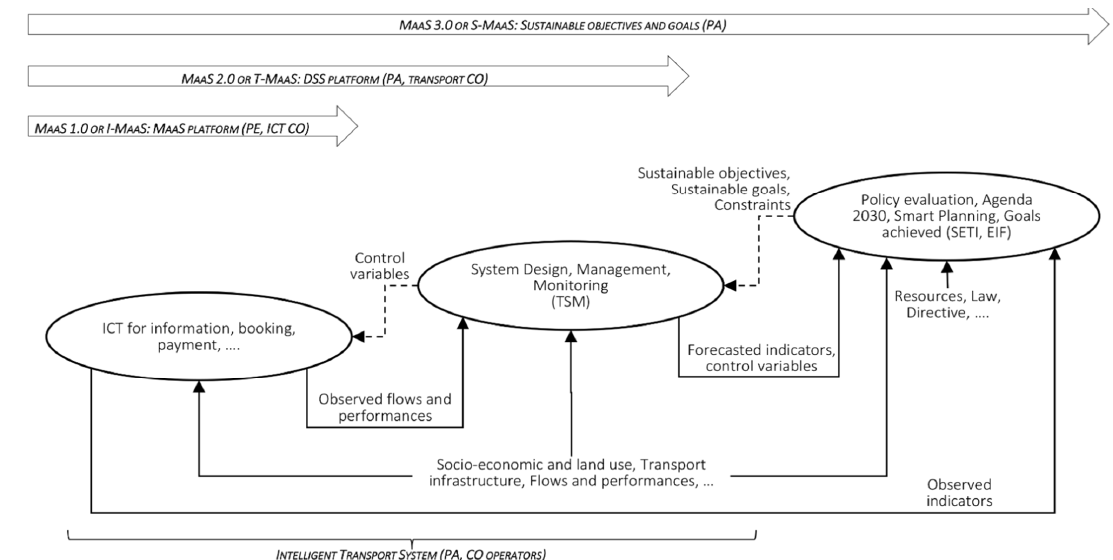
Figure 3. Architecture of MaaS 1.0, 2.0 and 3.0 and actors involved. MaaS 1.0, 2.0 and 3.0 require transport services integration. MaaS 1.0 requires the